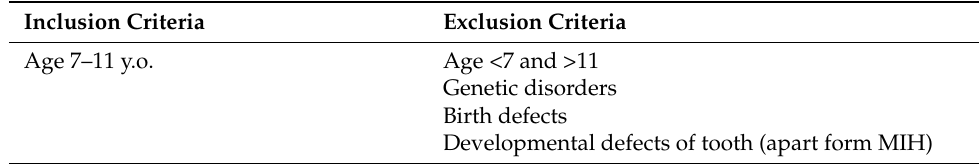
Table 1. Inclusion and exclusion criteria for the research. Inclusion